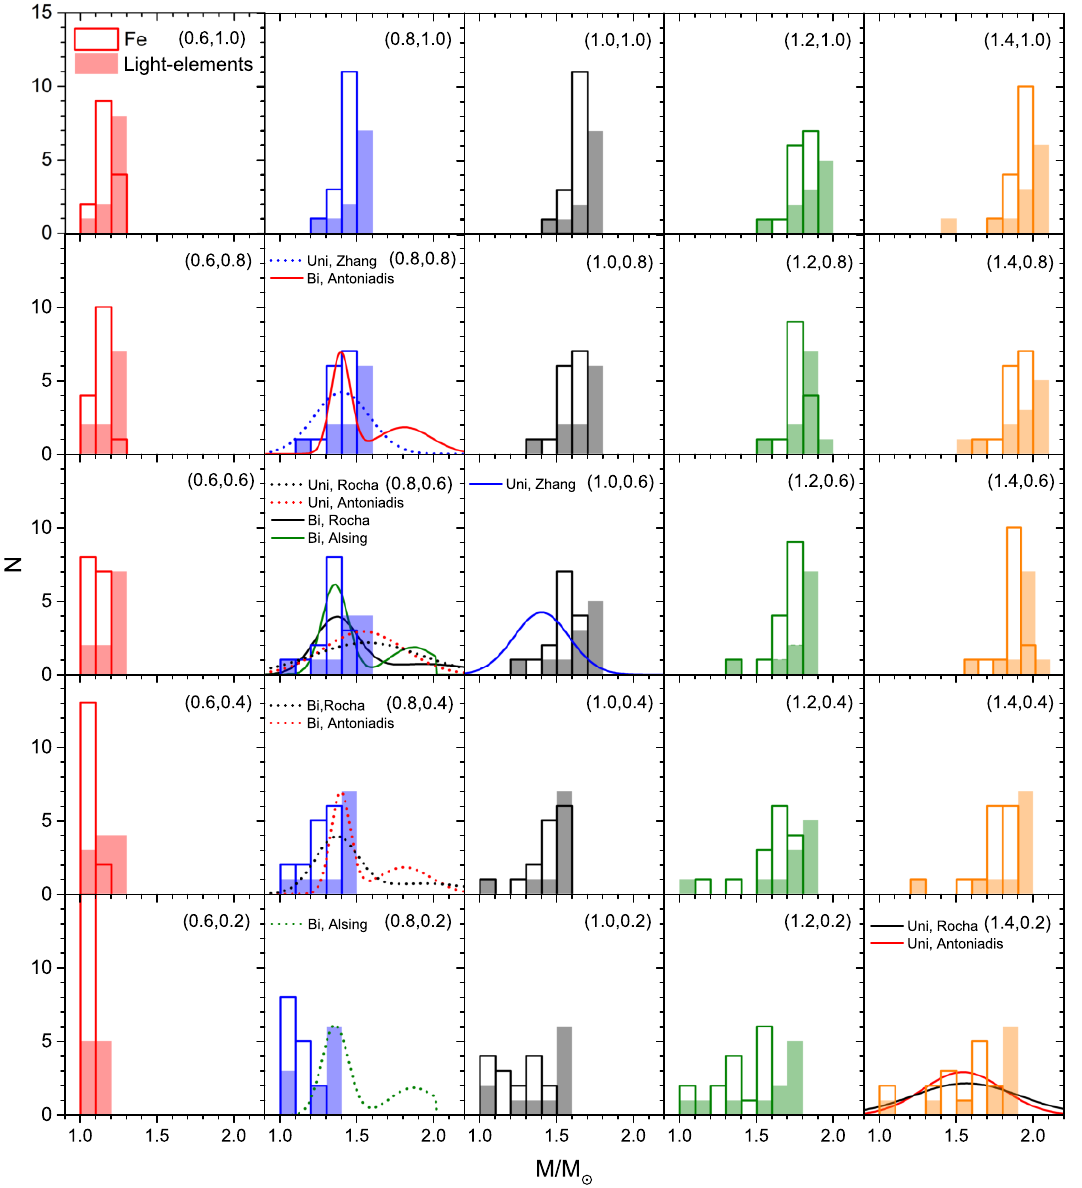
Figure 5. Deduced NS mass distributions for scaling factors ( s x = 0.6, . . . ,1.4 ) ⊗ ( s y = 0.2, . . . ,1.0 ) and with Fe (solid lines) or light-elements (shaded bars) atmosphere. N is the number of data points lying in a given mass interval ∆ M = 0.1 M (cid:12) in the proper ( s x , s y ) cooling diagram. Several panels show the best-fit theoretical results [82–85] of Figure 6 superimposed, using solid (dotted) lines for the Fe (light-elements)